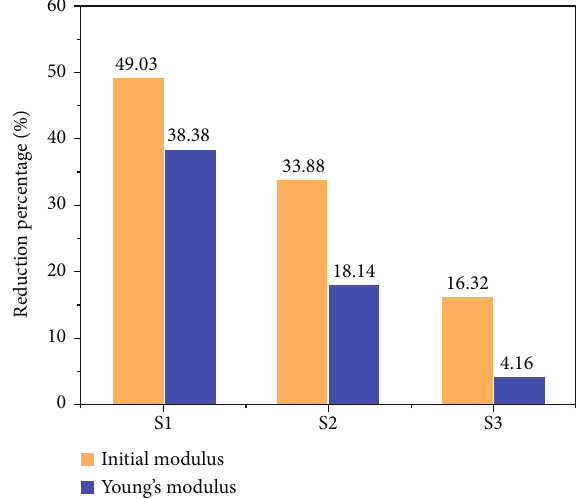
Figure 7: Reduction percentage of initial modulus and Young ’ s modulus after 40 WD